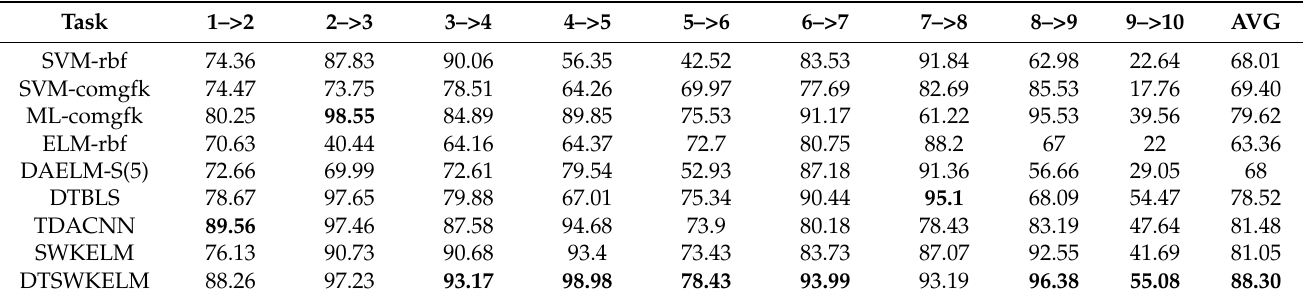
Table 3. The recognition effect of each algorithm in Experiment 2